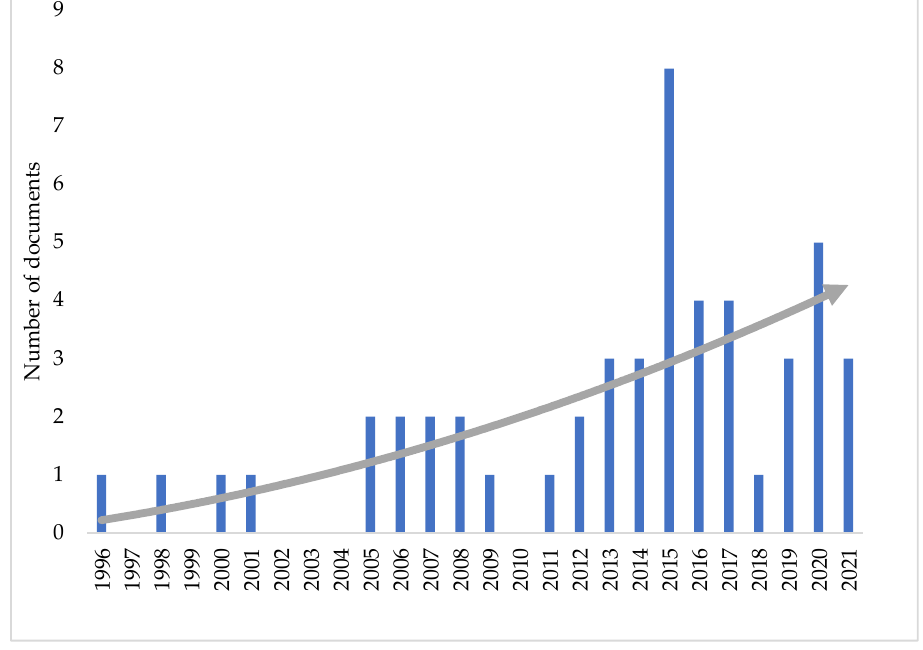
Figure 1. Number of documents (journal articles, letters and short surveys) published in last 25 years on Epichloë- derived antifungal activity and/or disease resistance.